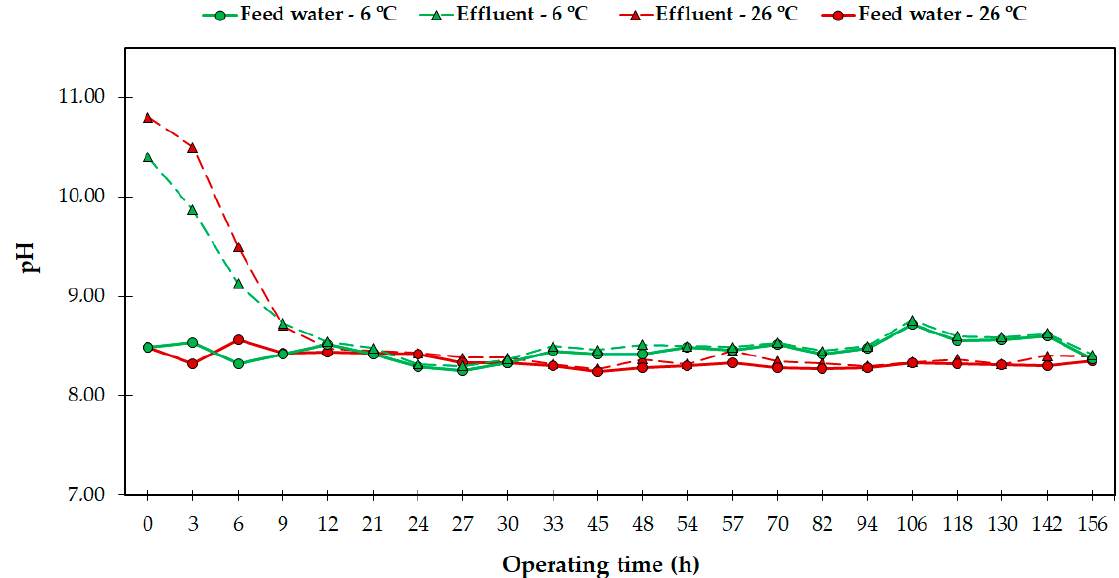
Figure 3. pH of the feed water and effluent during the tests performed.